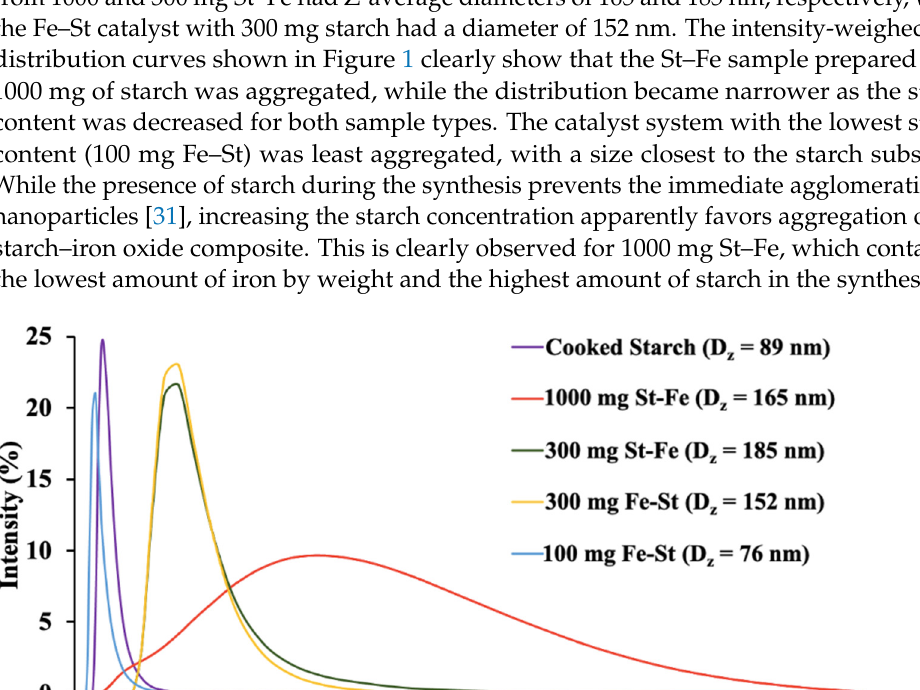
Figure 2. TEM imaging of St–Fe and Fe–St NPs as identified above. 3.2. Degradation of MB with Starch-Stabilized Iron Oxide Nanoparticles 3.2.1. Control Experiments The catalytic activity of starch-stabilized iron (Fe 2+/ Fe 3+ ) oxide NPs was studied with MB as a model pollutant. Since pH 3 is considered optimal for the Fenton reaction, control reactions were completed at this pH. It should be noted that, because the absorbance of a solution is proportional to the MB concentration, the ratio of the absorbance at time t to the initial absorbance (A t /A o ) was proportional to the relative concentration (C t /C o ), or the relative amount of dye left in the sample. Control experiments were carried out by exclud- ing one of the components required for the reaction (catalyst, H 2 O 2 , or UV light), while the concentrations of catalyst and H 2 O 2 were set at 290 μ mol/L Fe and 360 μ mol/L, respec- tively, which are typical concentrations used in the remainder of the investigation. As can